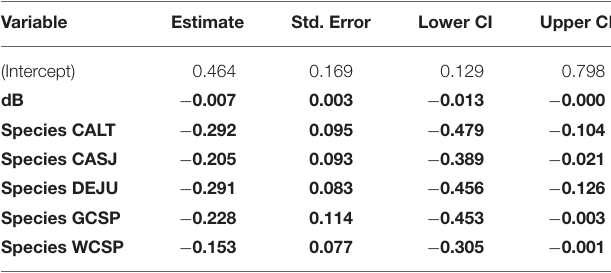
TABLE 3 | The influence of fixed effects on adjusted FID for ground foraging species. Variable